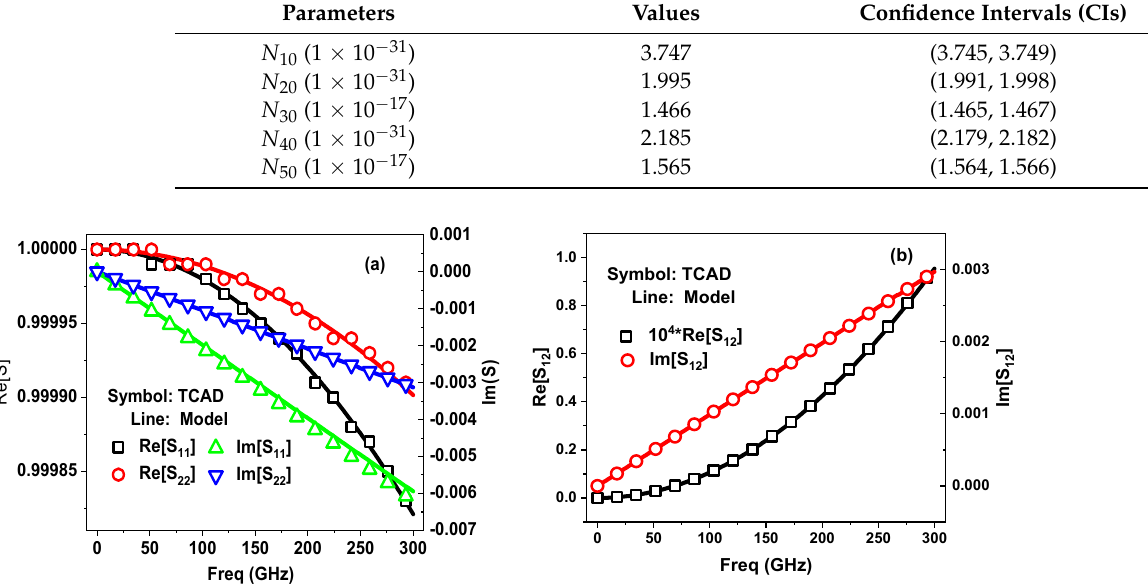
Figure 8. Comparison between simulated (symbols) and modeled S-parameters (solid lines) under OFF-state bias V gs = − 0.65 V, V ds = 0 V. ( a ) S11 and S22, ( b ) S12. Similar to the above OFF-state, the coefficients K i 0 for the ON-state can also be accu- rately determined. For example, the fitting results for the linear region ( V gs = 0.65 V, V ds = 0.05 V) are shown in Table 2. The reliability of K i 0 can also be proved by the corresponding narrow confidence interval. According to Equations (30)–(34), the bias-independent in- trinsic model parameters under such ON-state are calculated as: C gsi = 2.968 × 10 − 17 F, C gdi = 2.77 × 10 − 17 F, R gsi = 916.33 Ω , R gdi = 1331.3 Ω , τ m = 32.2 fs, g m =2.71 × 10 − 5 S, C sdx = 1.90 × 10 − 18 F and R ds = 2357 Ω . S-parameter comparison between the Sentaurus device simulation and ADS equivalent circuit simulation under a linear region ( V gs = 0.65 V, V ds = 0.05 V) and saturation region ( V gs = 0.65 V, V ds = 0.65 V) is depicted in Figure 9. Excellent agreement is obtained over the entire frequency. The maximum error in the linear region and saturation region are 0.2504% and 2.689%, which confirms the accuracy of the proposed extraction method. Table 2. The fitted constant K i0 and the corresponding confidence interval under V gs = 0.65 V, V ds = 0.05 V.